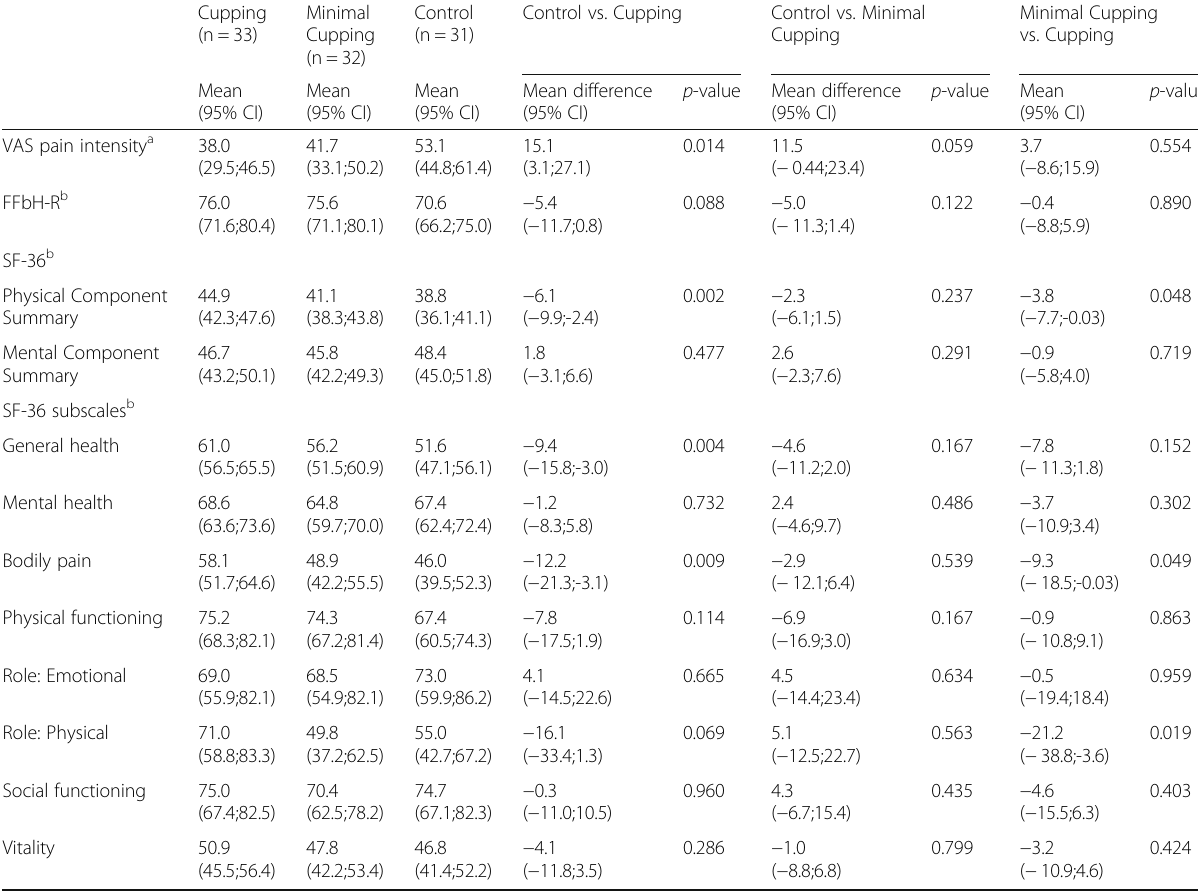
Table 3 Secondary outcomes at week 12: group means and mean group differences with 95% confidence interval (CI), adjusted for respective baseline